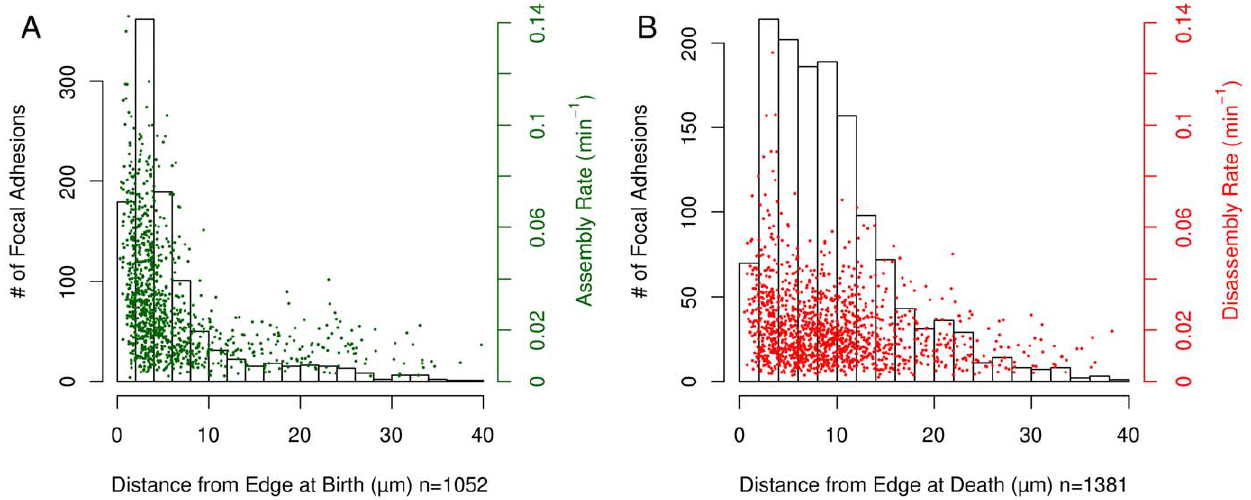
Figure 4. Spatial properties of FA positions at birth and death. (A) The majority of adhesions are born within 5 m m of the cell edge and the greatest variance in assembly rates are also observed in this 5 m m band. (B) The distribution of the distance of death location from the cell edge indicates that adhesion disassembly typically occurs along a broader band from the cell edge as compared to the position at adhesion birth. Also, the variance in disassembly rate is roughly the same regardless of the position at adhesion death. This data was collected from 21 EGFP-Paxillin cells.